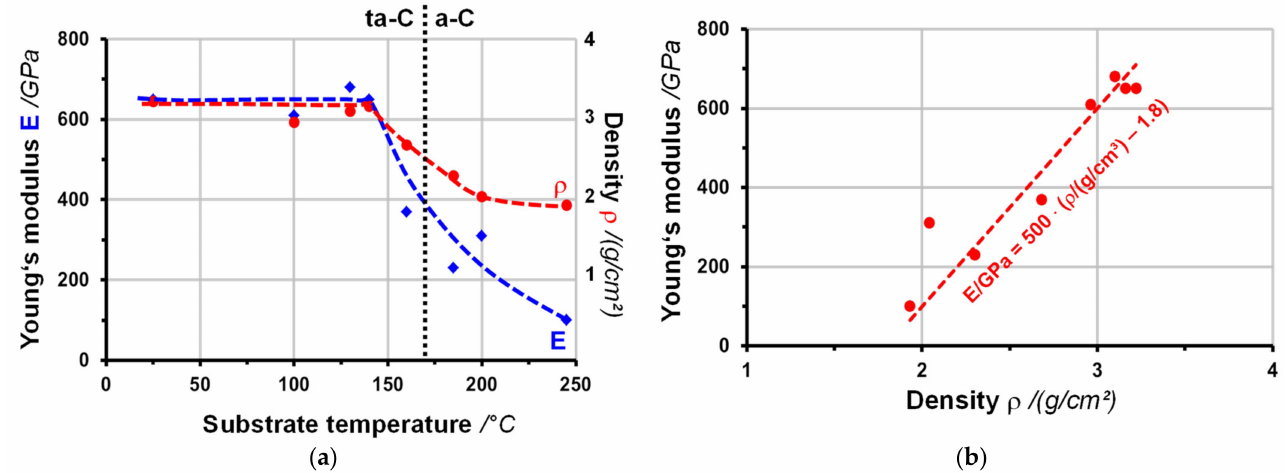
Figure 7. ( a ) Young‘s modulus and density of carbon films, deposited by MSIBD with 120 eV ions, in dependence on the substrate temperature (data from [52,53]). E and ρ have been determined by laser acoustics. ( b ) Relation between Young‘s modulus and density of carbon films, deposited by MSIBD with 120 eV ions at temperatures between room temperature and 250 ◦ C (data from ( a )). Included is the relation Equation (3) for E( ρ